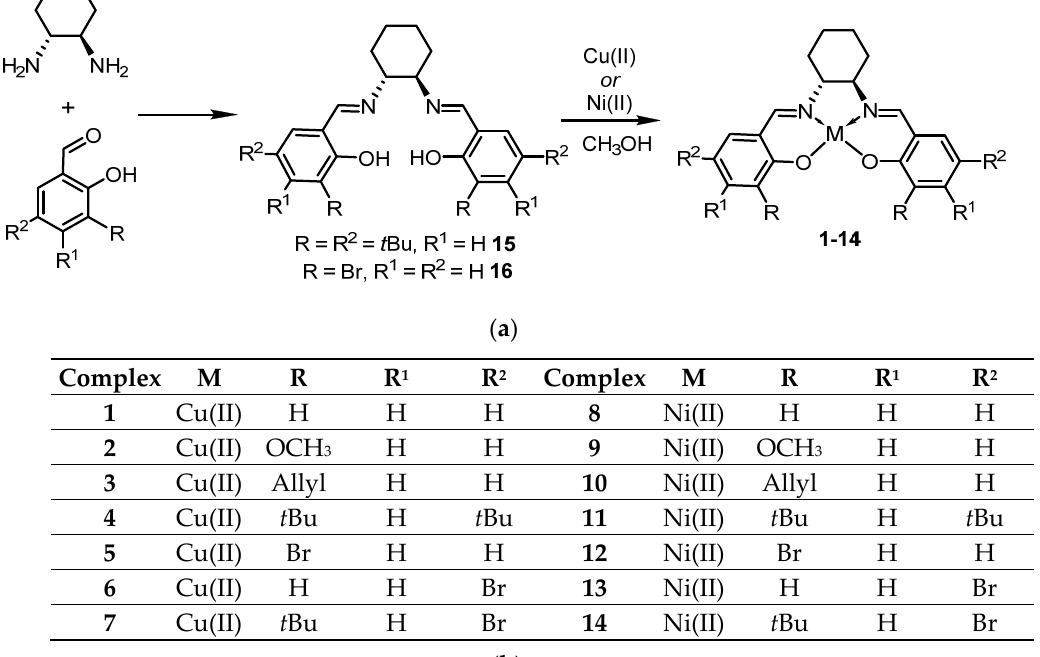
Scheme 1. Synthetic procedure adopted by us for the synthesis of the Cu(II) and Ni(II) salen com- plexes described in our work ( a ). The identity of metal and substituents is indicated for all